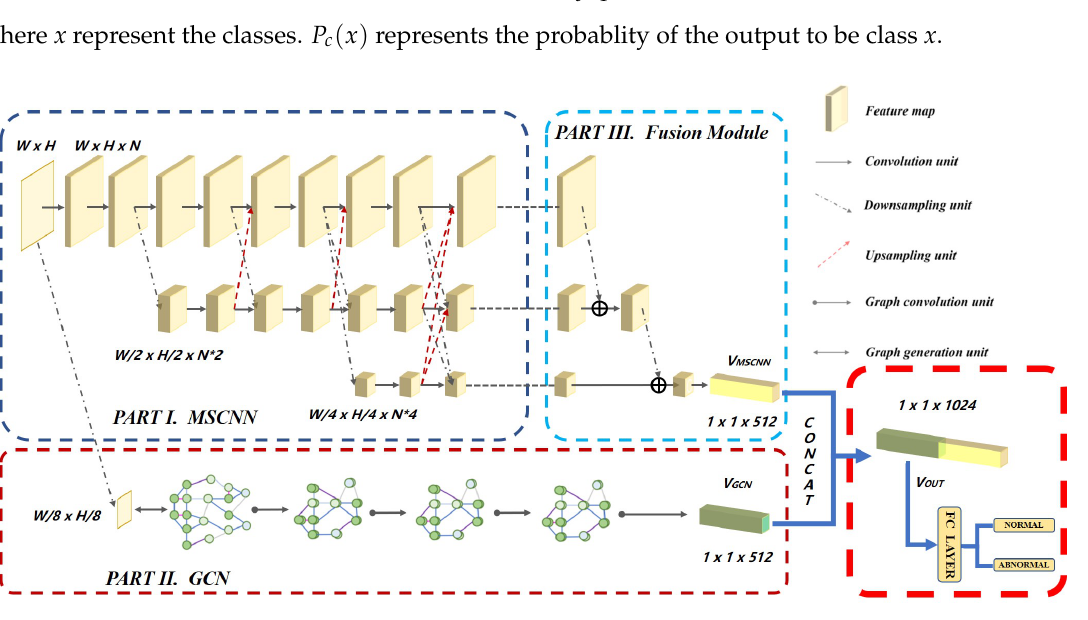
Figure 2. Proposed network